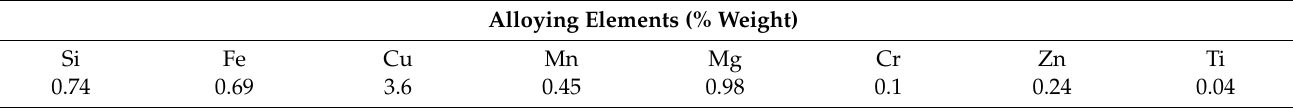
Table 1. Composition of PA6 determined by SEM. Alloying Elements (% Weight)